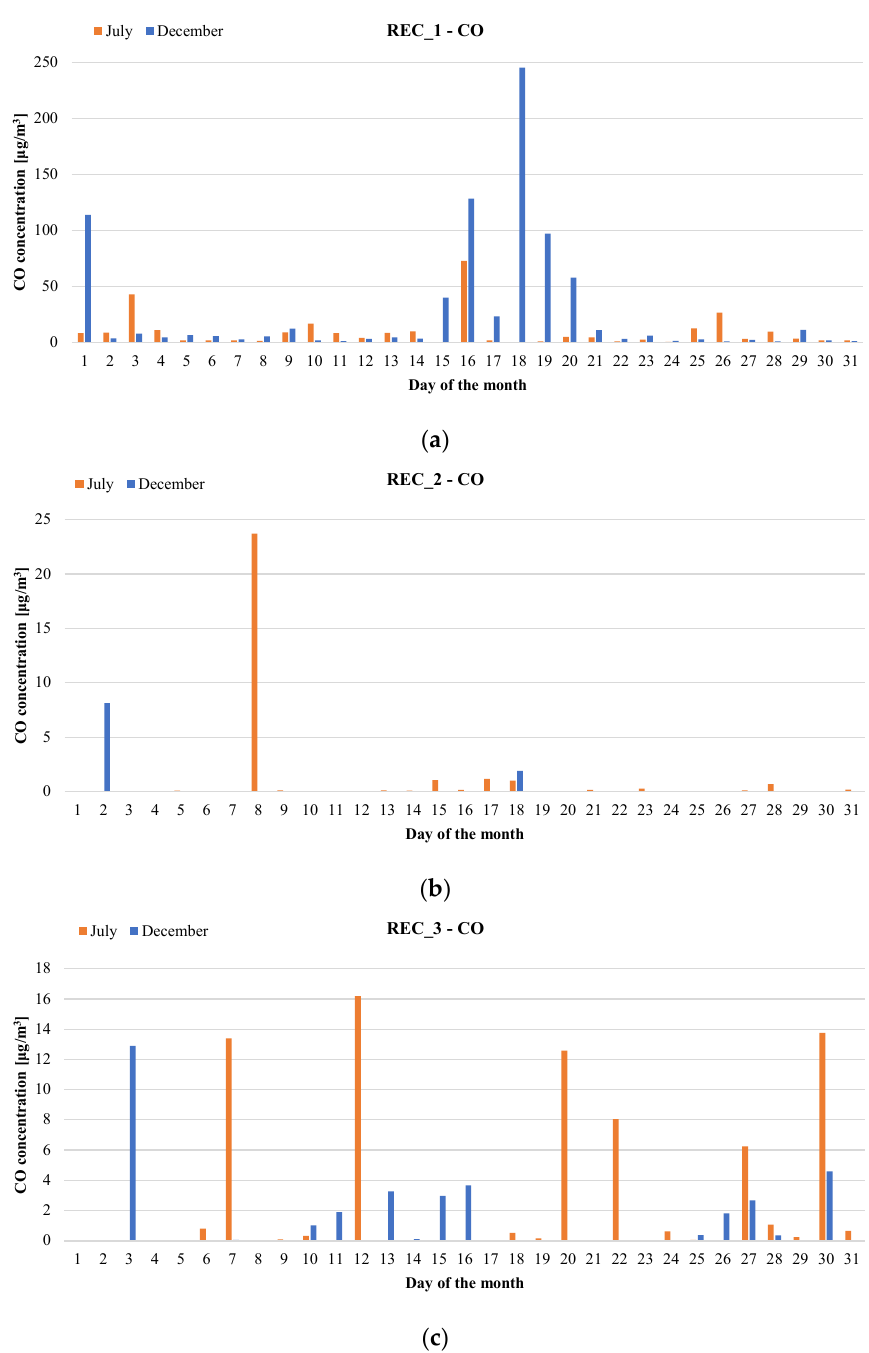
Figure 3. Average 24 h CO concentrations at ( a ) REC_1, ( b ) REC_2 and ( c ) REC_3 receptors.